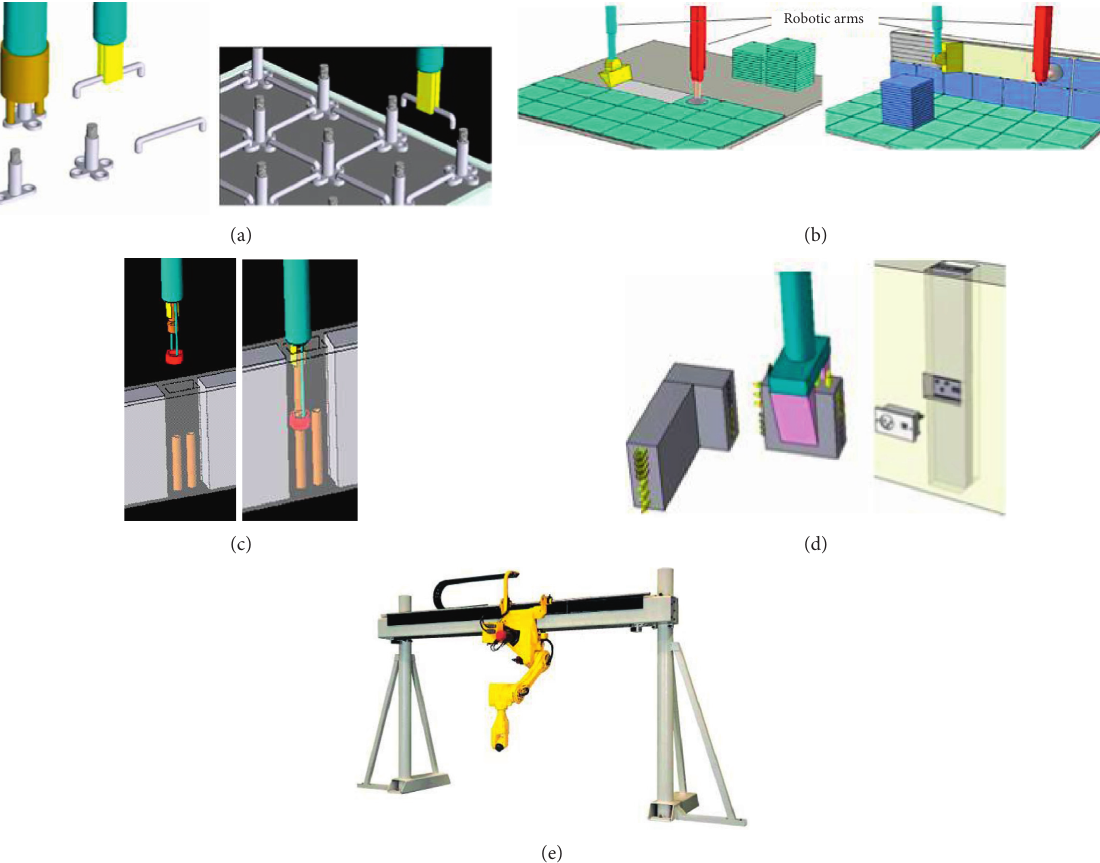
Figure 4: CC features: (a) automated reinforcement; (b) automated tiling of floors and walls; (c) automated plumping; (d) automated electrical and communication line wiring; (e) automated painting